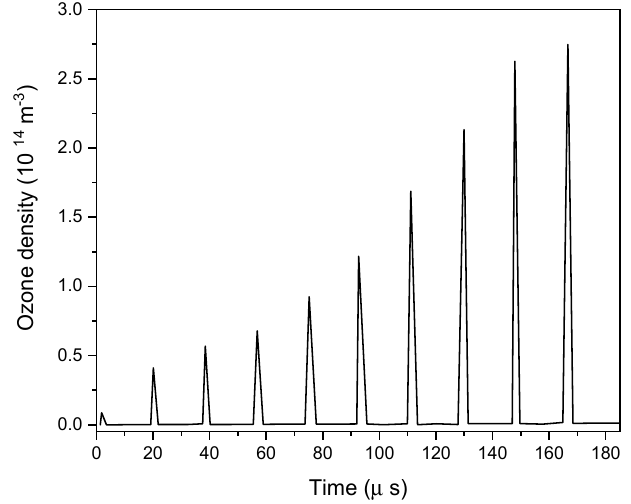
Figure 9. Ozone production and accumulation in the DBD reactor as a function of time.